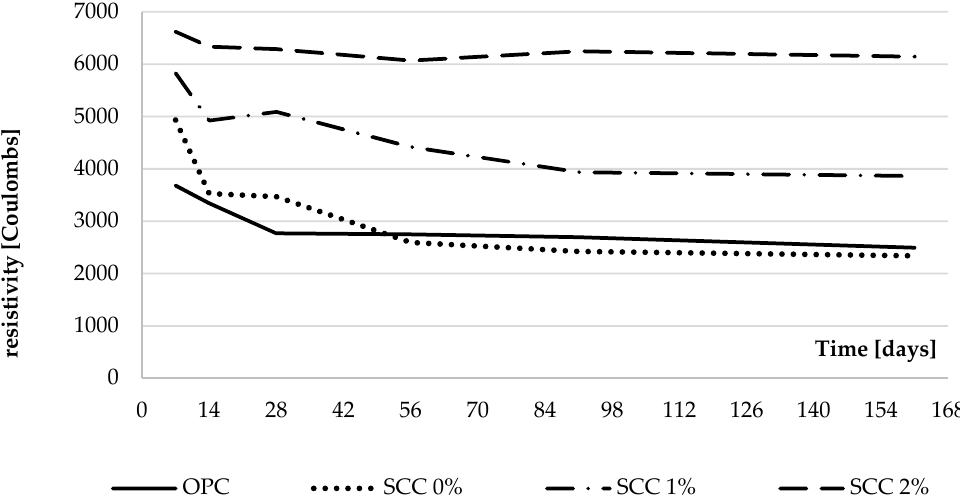
Figure 4. Results of time-dependent surface electrical resistivity of concrete.